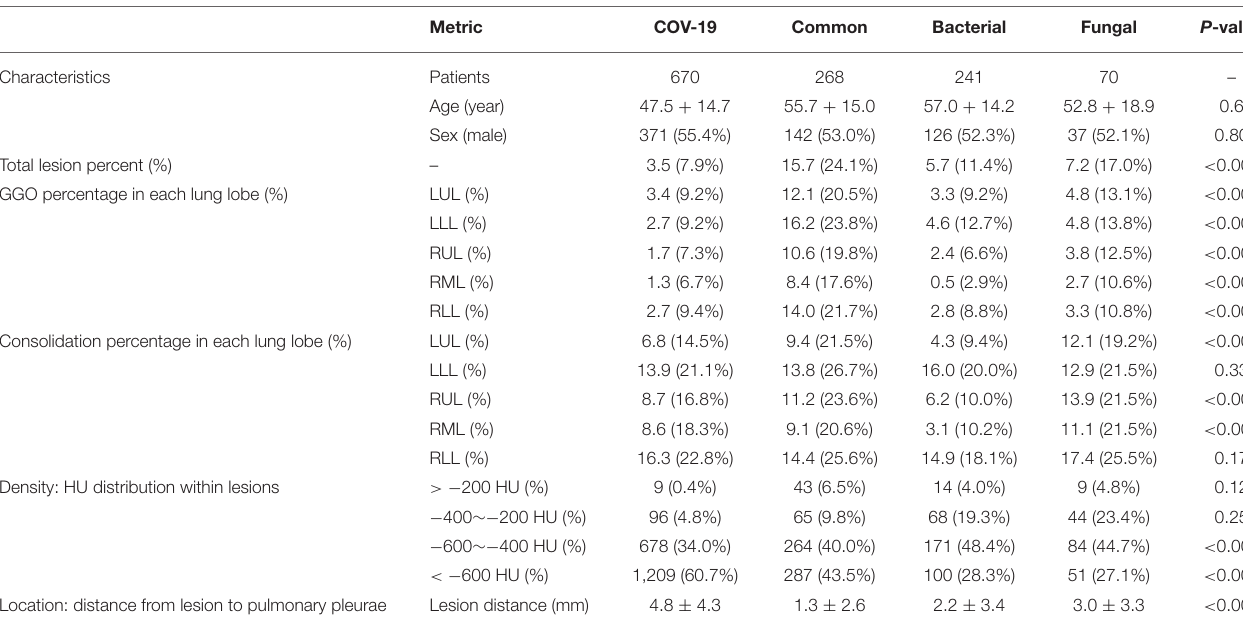
TABLE 3 | Lesion characteristics in CT image of different types of